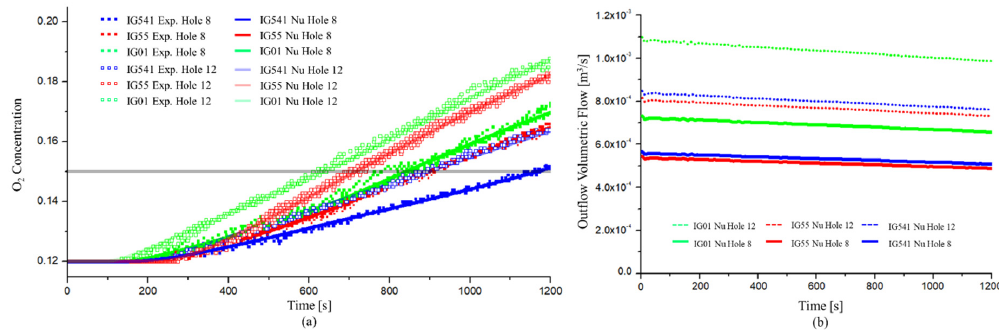
Figure 12. Comparison of experimental and numerical results for the retention time of each agent: ( a ) O 2 concentration over time; ( b ) outflow volumetric flow 𝑉(cid:4662) (cid:3042) over time.